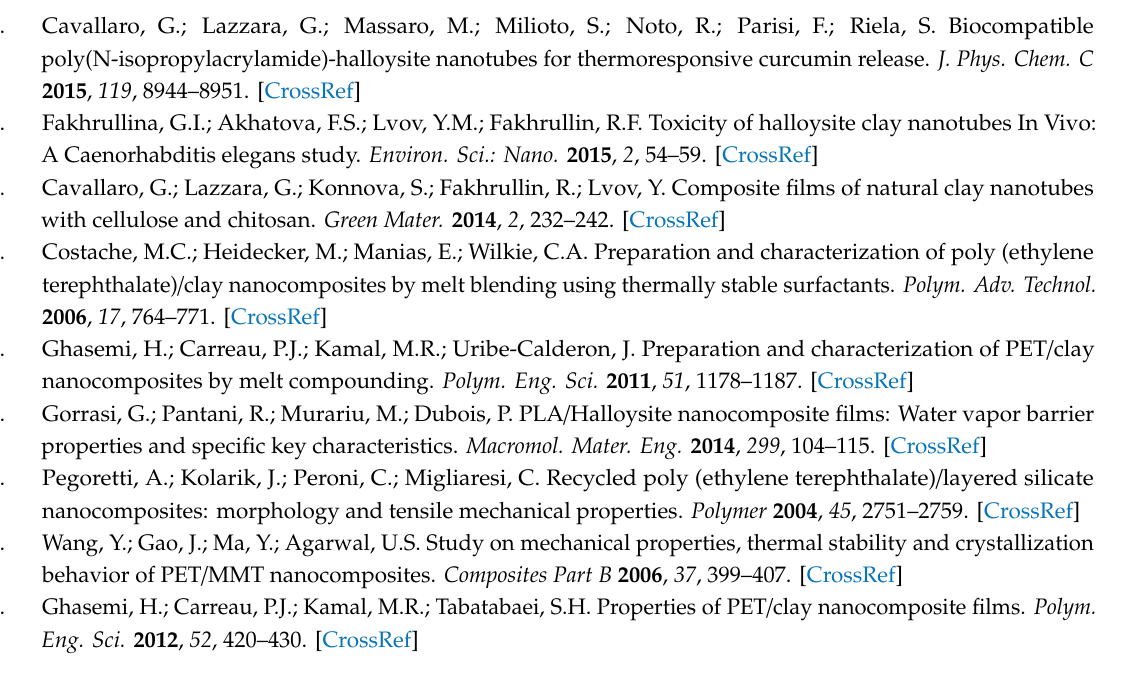
Figure S1: Schematic illustration of fabrication technique of nanocomposite films; Figure S2: Optical camera images of nanocomposite films before (a) and after drying (b); Figure S3: ATR-IR spectra of kaolinite (a), choline chloride modified kaolinite nanocomposites (b) and choline chloride (c); Figure S4: XRD patterns of kaolinite and choline chloride modified kaolinite; Figure S5: Engineering stress–strain relationships; Figure S6: SEM images of kaolinite (A) and choline chloride modified kaolinite (B)